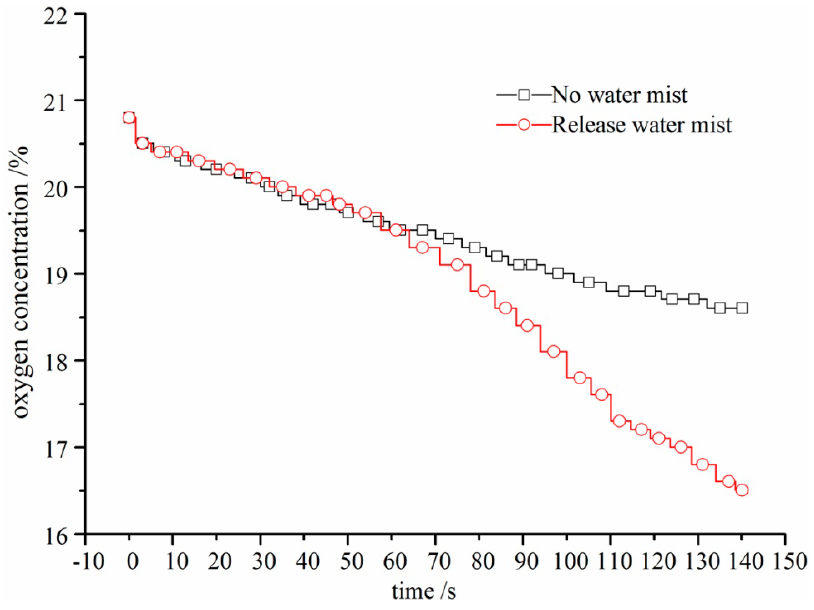
Figure 9. Variation tendencies in oxygen concentration after application of water mist.